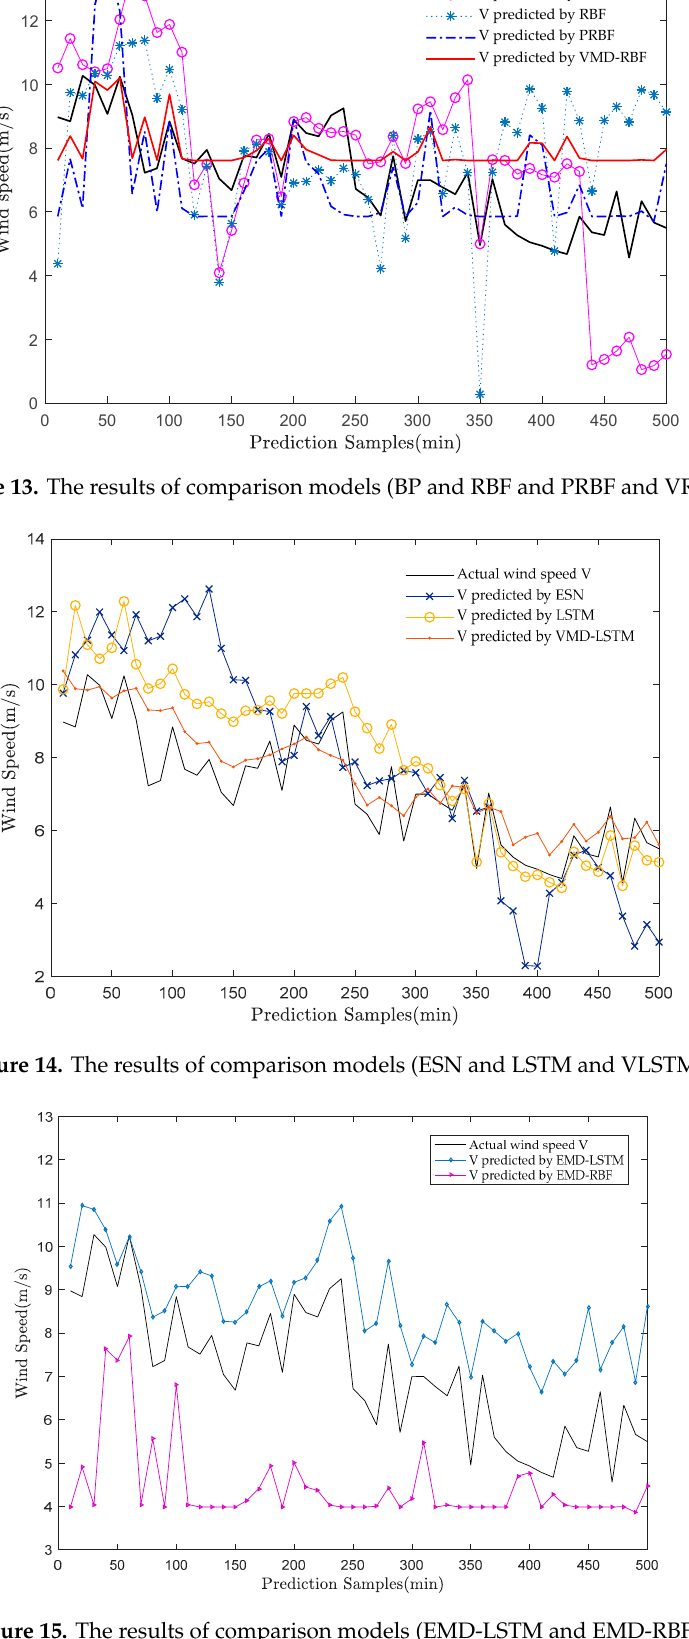
Figure 15. The results of comparison models (EMD-LSTM and EMD-RBF).